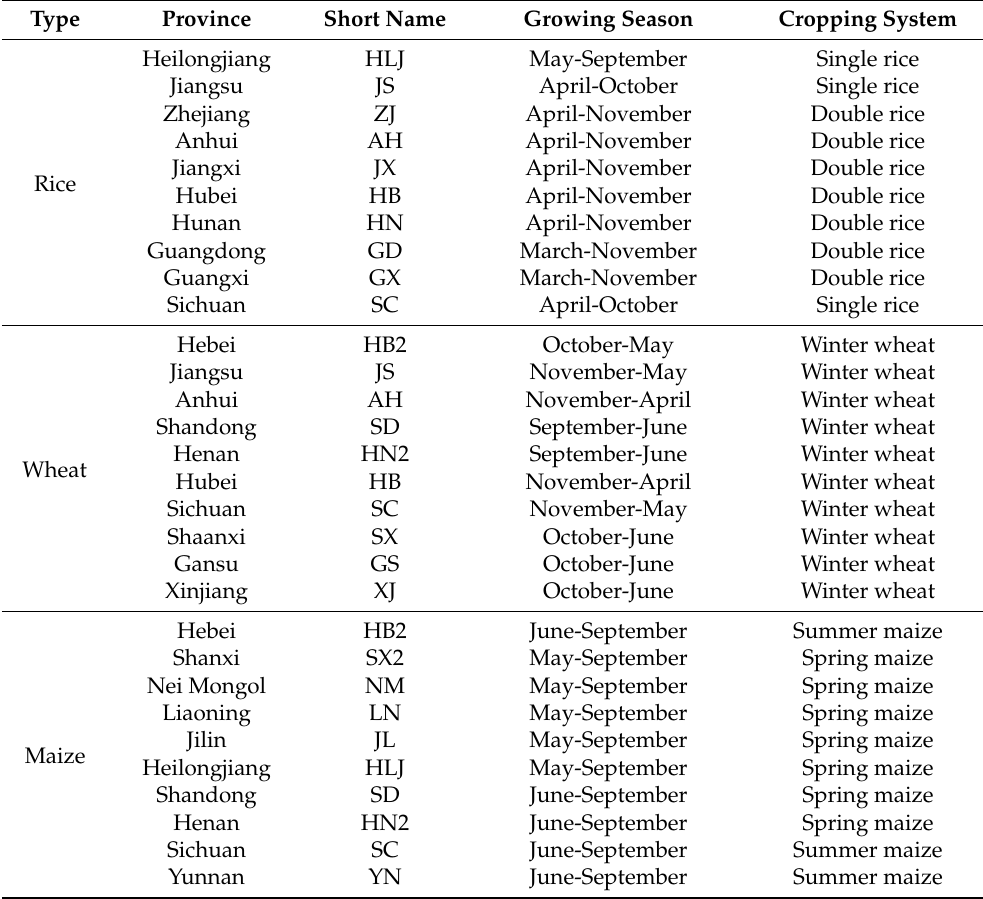
Table 1. Crop-producing information for each crop-province